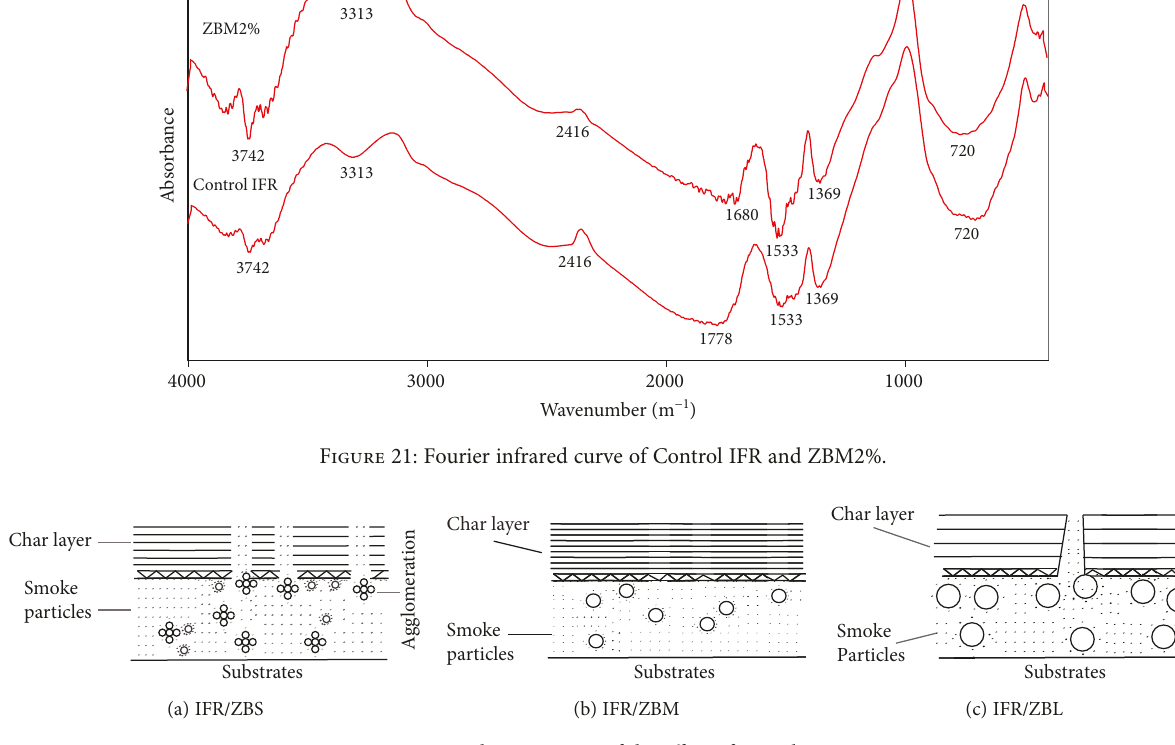
Figure 22: Schematic view of the e ff ect of particle